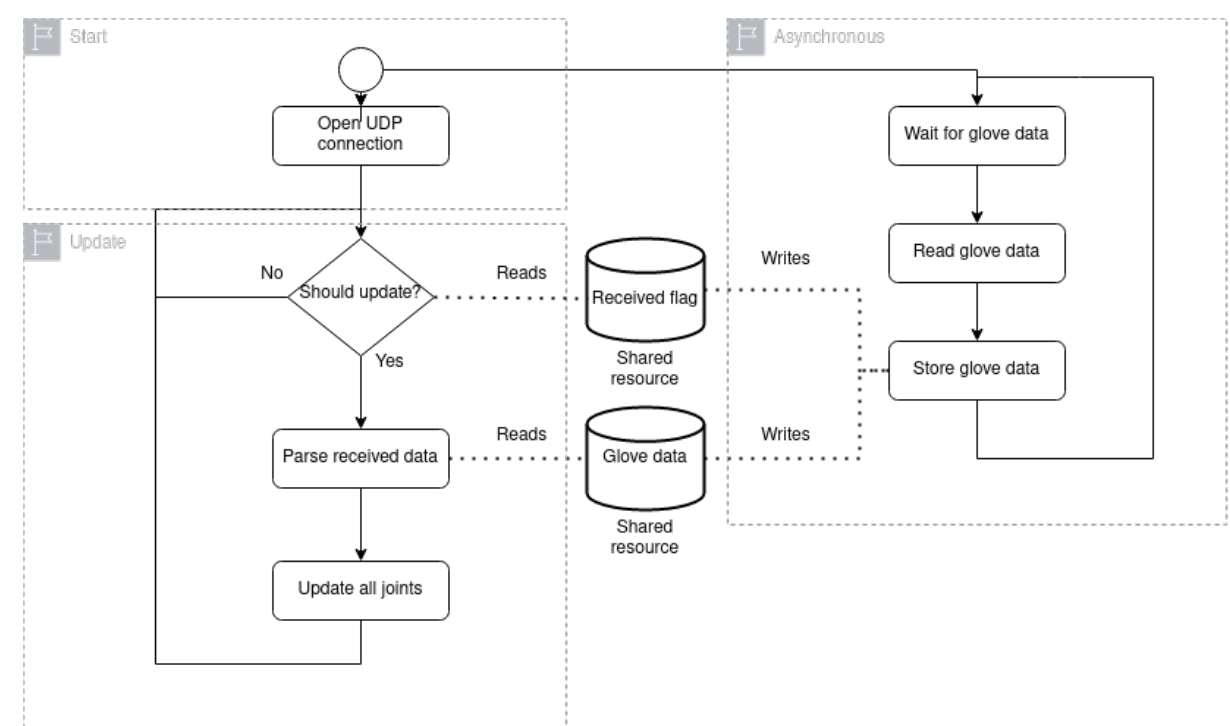
Figure 5. Simulation program